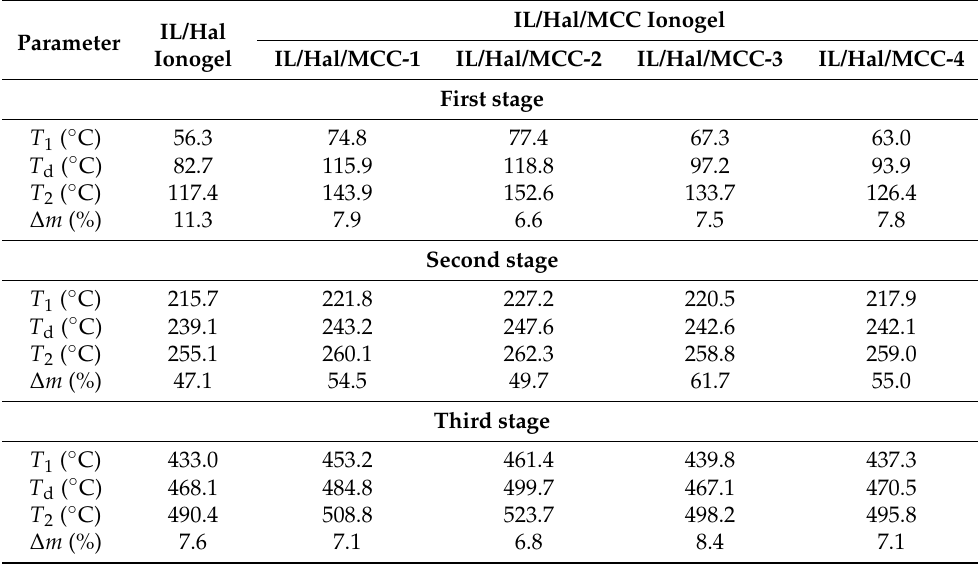
Table 5. Characteristic temperatures and weight loss values for IL/Hal/MCC